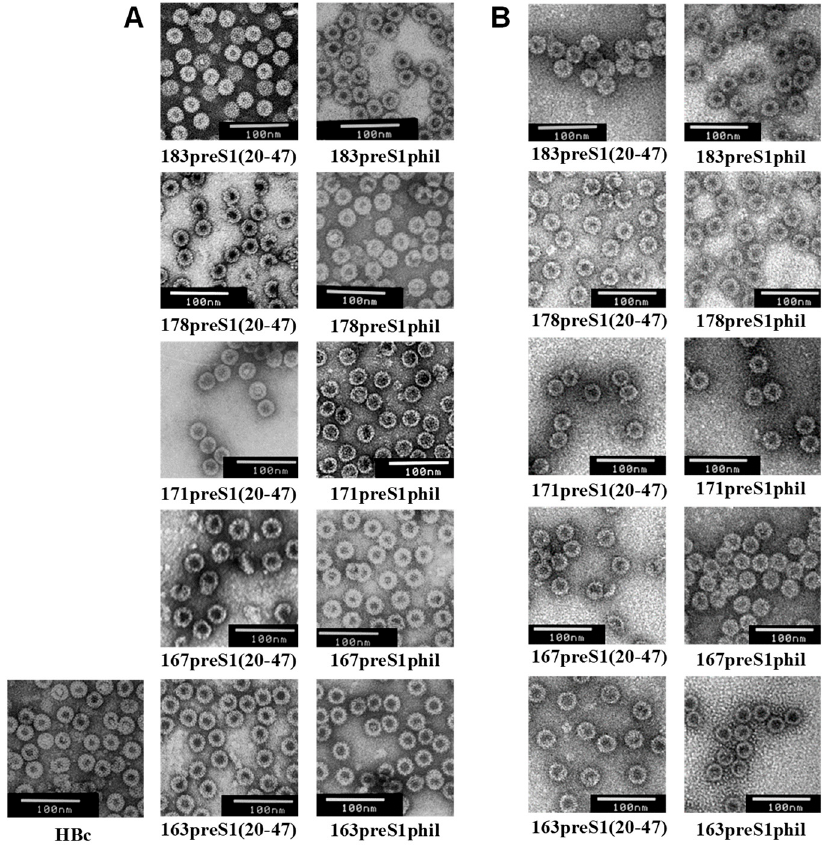
Figure 8. EM of HBc-preS1 VLP preparations. ( A ) Original preparations (years 2016—2018); ( B ) the same samples in the year 2021. Scale bar, 100 nm.